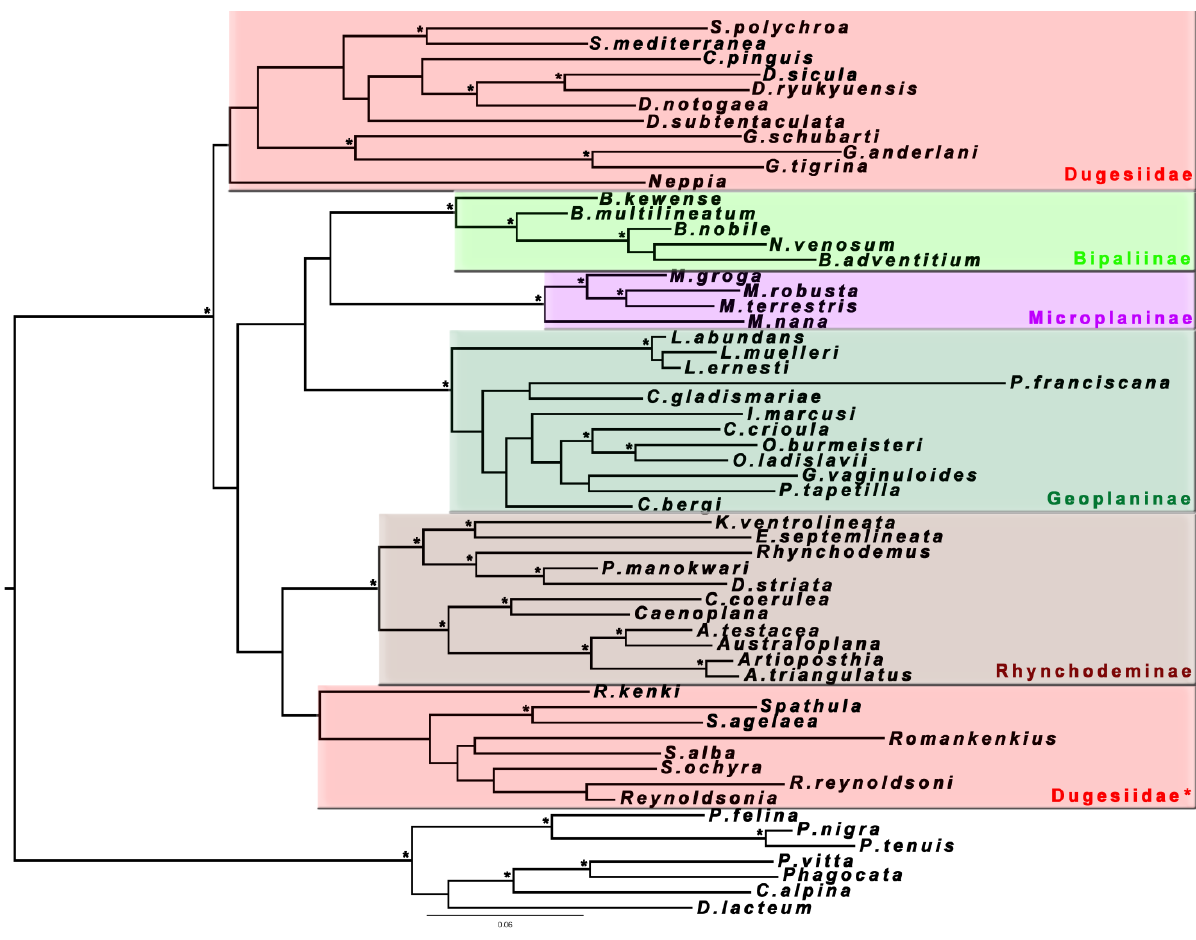
Figure 1. Maximum likelihood phylogenetic tree obtained from a concatenated dataset ( 18S rRNA type II , 28S rRNA and Elongation Factor 1α genes) for the Continenticola (see text). Terrestrial planarians: subfamilies Bipaliinae, Microplaninae, Geoplaninae and Rhynchodeminae; the freshwater Family Dugesiidae is polyphyletic; outgroup: Superfamily